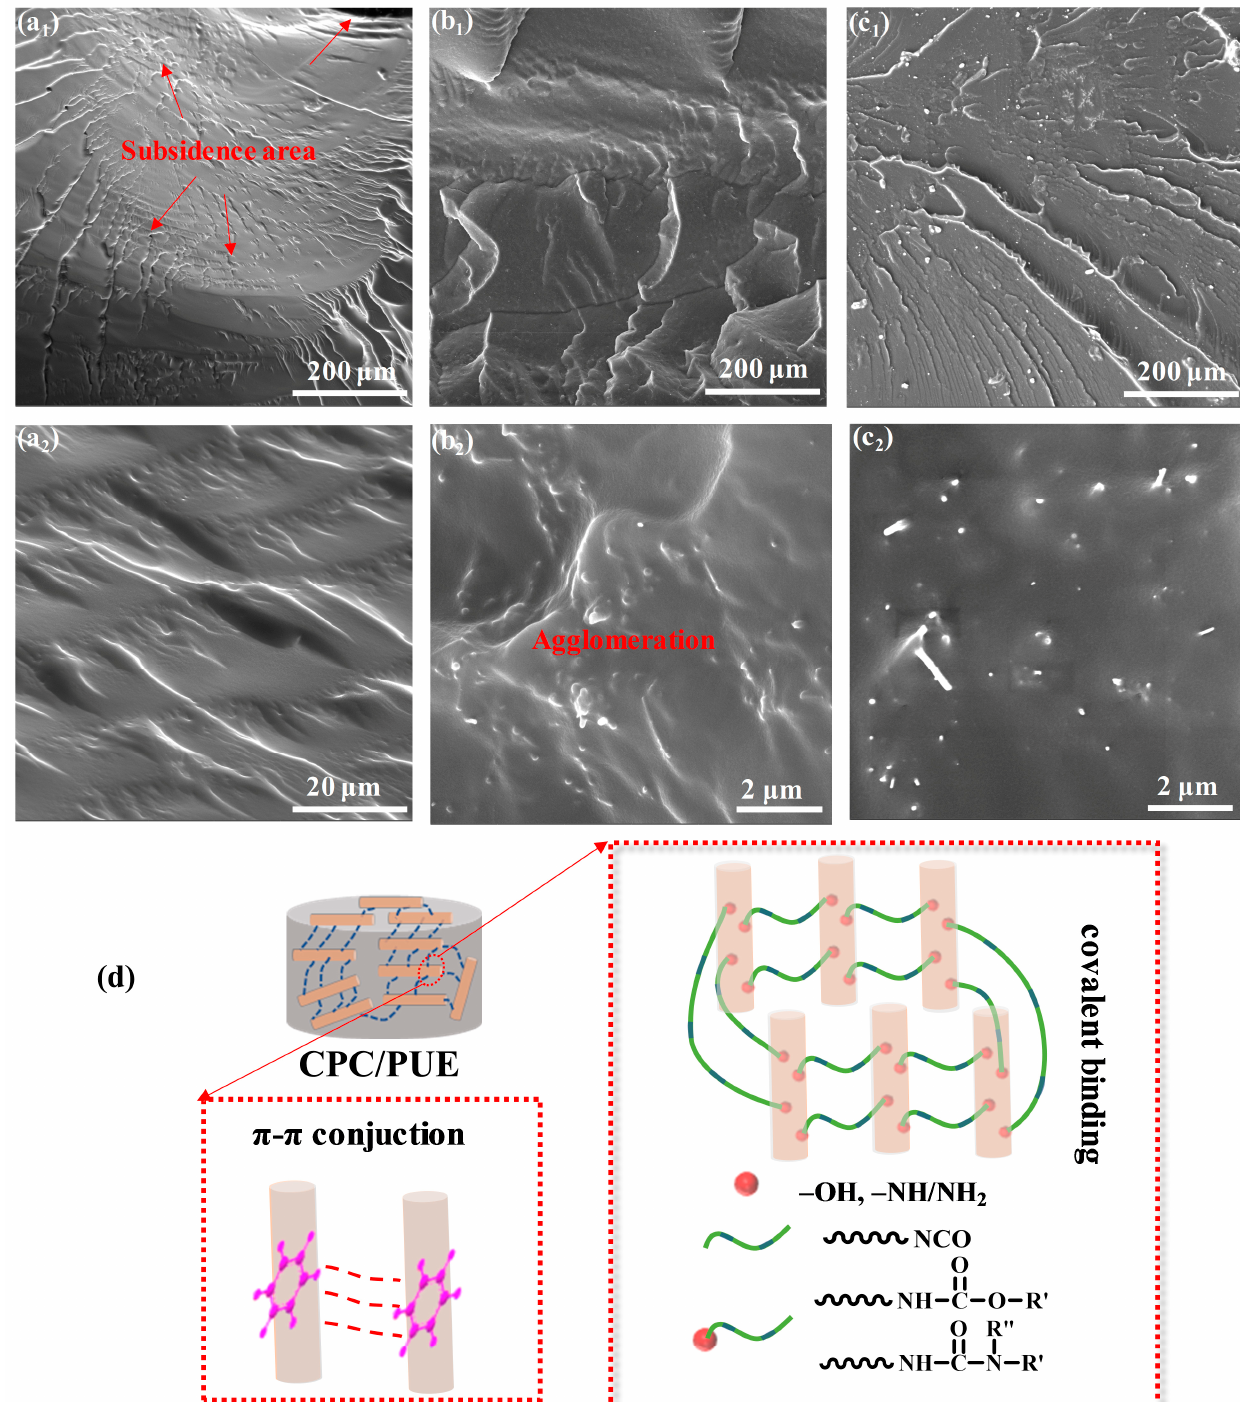
Figure 8. The SEM surface microtopography of the PUE sectional views of ( a 1 , a 2 ) the neat PUE, ( b 1 , b 2 ) CNFs/PUE, and ( c 1 , c 2 )CPC/PUE–V after SHPB test via liquid nitrogen quenching. ( d ) Schematic illustration of the excellent impact resistance of CPC/PUE.